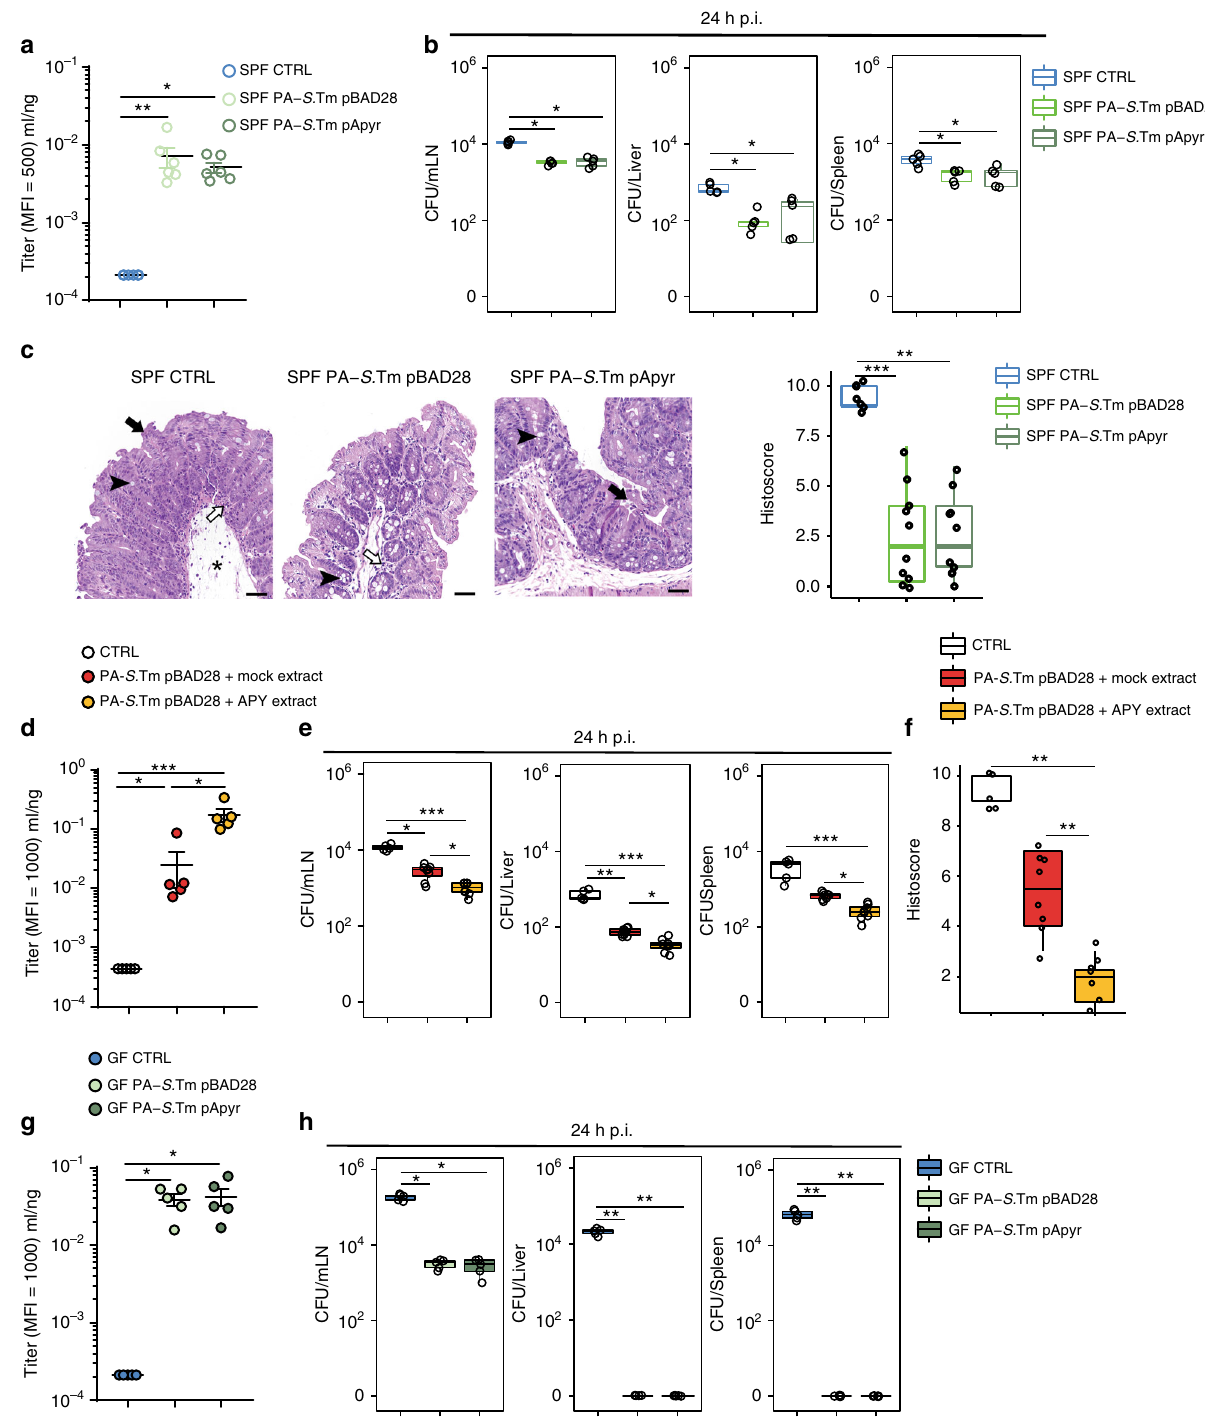
Fig. 6 Apyrase enhances the induction of IgA by inactivated oral vaccines. SPF and GF mice were untreated (CTRL) or immunized with PA- S .Tm transformants together with crudely-puri fi ed apyrase (APY extract) or mock extract (mock extract) where indicated, pretreated with streptomycin, infected with S .Tm WT (10 8 CFU i.g.) and analysed 24 h later. a Intestinal lavage IgA titer and b pathogen loads (CFU) in mLN, liver and spleen in SPF mice either non-immunized (CTRL) or immunized with PA- S .Tm pBAD28 or PA- S .Tm pApyr . c Representative H&E sections of the cecum from SPF mice at 24 h post infection and statistical analysis of histopathological scores. Star: submucosal edema; white arrow: neutrophils aggregates; black arrow: epithelial defects; arrowhead: goblet cells. Scale bar: 50 µ m. d Intestinal anti- S .Tm IgA titer, e pathogen loads (CFU) in mLN, liver and spleen and f statistical analysis of histopathological scores in non-immunized mice (CTRL) and mice immunized with PA- S .Tm pBAD28 conditioned with the indicated extract. g Intestinal lavage IgA titer and h pathogen loads (CFU) in mLN, liver and spleen in GF mice either non-immunized (CTRL) or immunized with PA-S.Tm pBAD28 or PA-S. Tm pApyr . The boxplots show median and upper and lower quartiles. The extreme lines show the highest and lowest value . The boxplot is overlaid with the visualization of single observations. Kruskal – Wallis with Dunn ’ s post-test. * p < 0.05, ** p < 0.01, *** p < 0.001. One representative experiment out of two